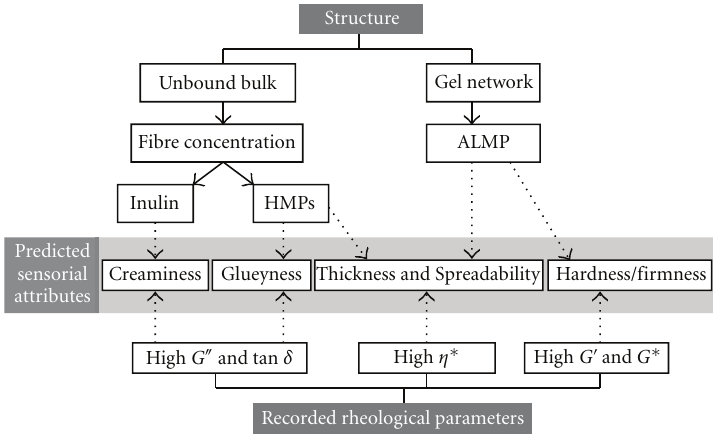
Figure 1: Conceptual model on the relations among structure, rheological properties, and predicted sensory attributes of pectin-based (mixed fibre) functional gel systems formulated by Haghighi et al. [26] (HMPs: high methoxyl pectins; ALMP: amidated low methoxyl pectin; G (cid:3) : storage modulus; G (cid:3)(cid:3) : loss modulus; η ∗ : complex viscosity; tan δ : loss tangent; G ∗ : complex